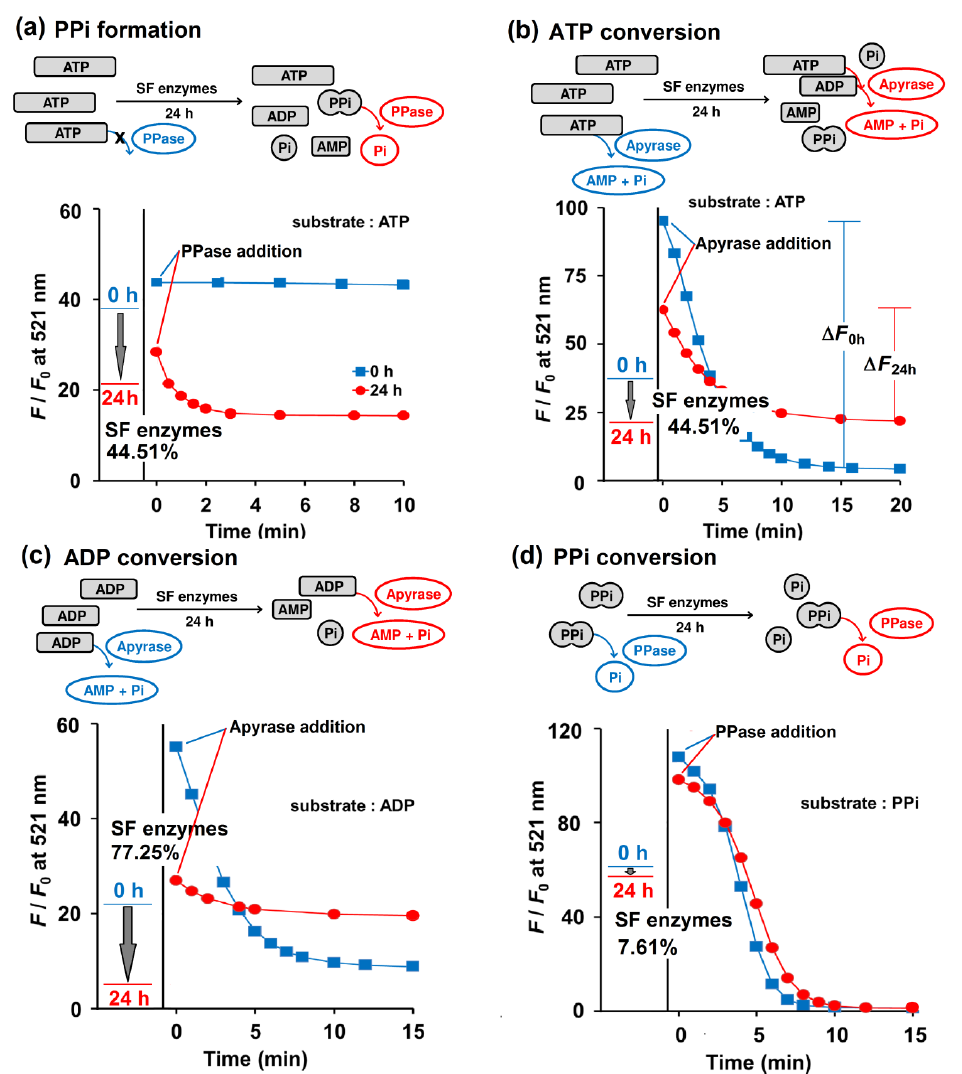
Figure 4. Enzymatic activities of SF No. 1 when 1 mM ATP ( a , b ), 1 mM ADP ( c ), and 1 mM PPi ( d ) were employed as a substrate, as reported by Kyoto Green (1 µ M). The F / F 0 values of Kyoto Green at 0 th and 24 th h after incubation of the substrate with SF, are displayed as a blue and red line, respectively. The incubated mixtures at 0th (blue square) and 24th h (red circle) were 100-fold diluted and further treated with 0.074 ng/ μ L PPase ( a , d ) and 0.33 ng/ μ L apyrase ( b , c ) then monitored by Kyoto Green (1 μ M). Measurement conditions: 50 mM HEPES buffer (pH 7.4, 25 °C, λ ex = 488 nm).